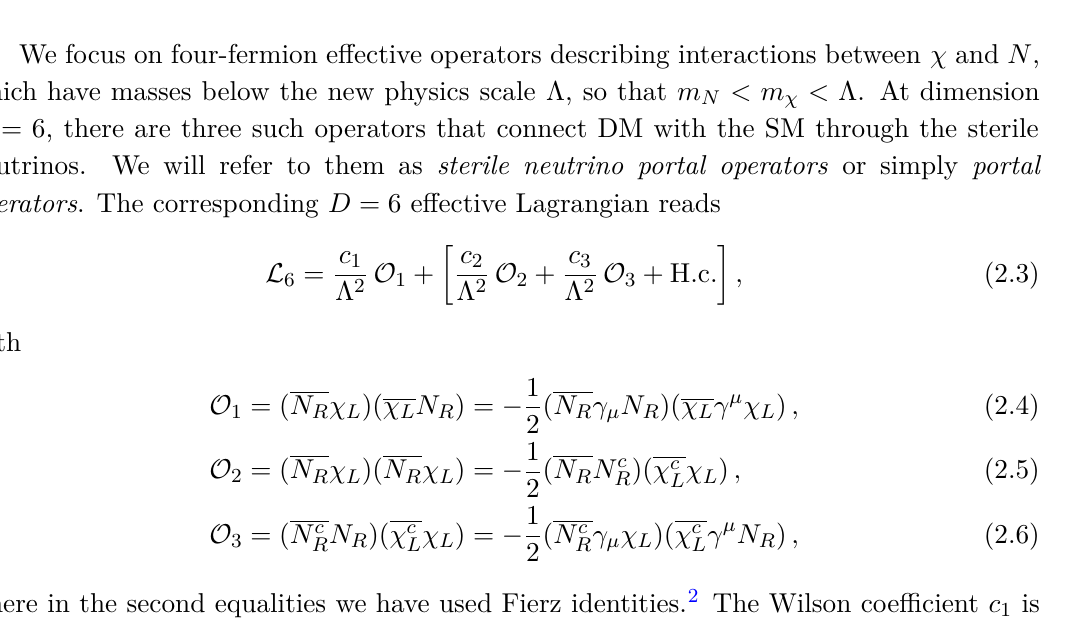
Table 1 . Structure of the effective D ≤ 6 operators generated by renormalisable models considered in section 3. All operators, but O mediator at tree level. The operator O defined in eq. (3.17). For this operator, generated in Model B2, Ψ stands for the fields carrying non-zero lepton number, i.e. Ψ = N O ψψ , O Nψ and O χψ , ψ stands for the SM fermions, i.e. ψ = L , e R , Q , u R , d R